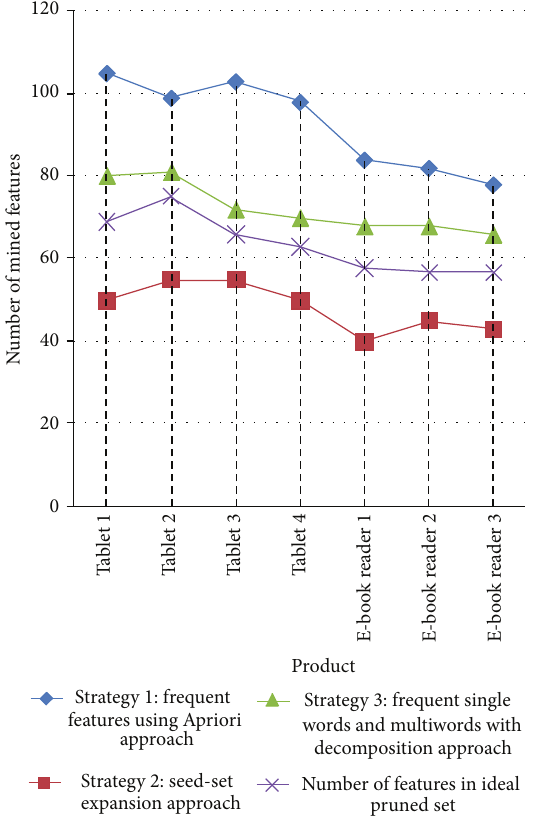
Figure 3: Comparison of feature extraction